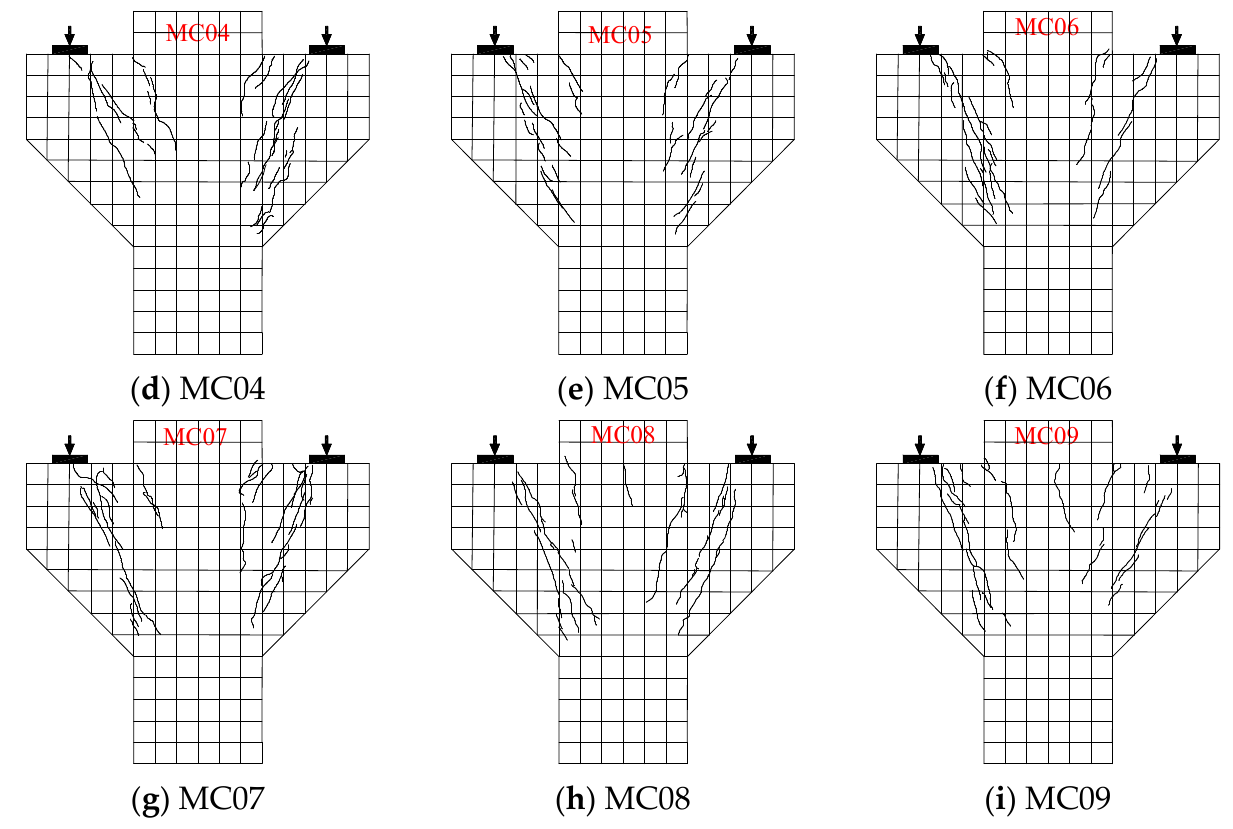
Figure 3. Crack failure pa tt erns of the specimens.